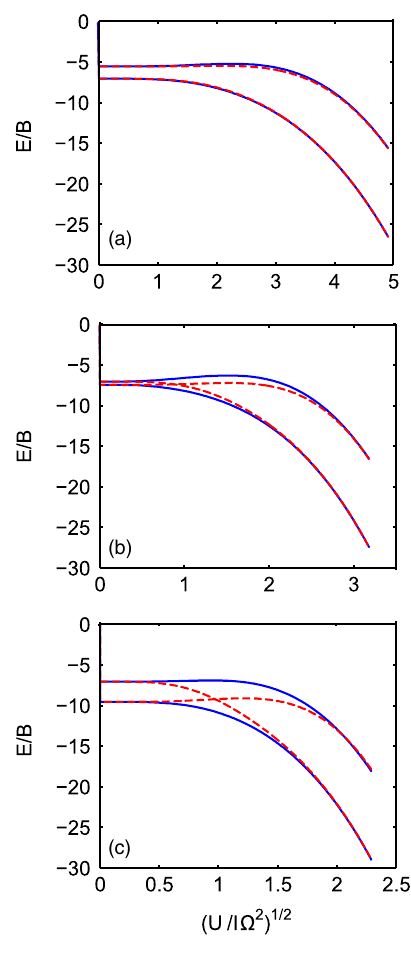
FIG. 4. Diagonal matrix elements of the rotating frame Hamiltonian, H R Eq. (7), expanded in the basis of eigenstates of the stationary pendulum, H p Eq. (12) (dashed lines). When the rotating frame Hamiltonian is diagonalizied, the eigenvalues exhibit avoided crossing when (cid:1) > (cid:1) crit (solid lines). (cid:1) ¼ 1 : 75 (a), 2.7 (b), and 3.75 (c) in units of B @